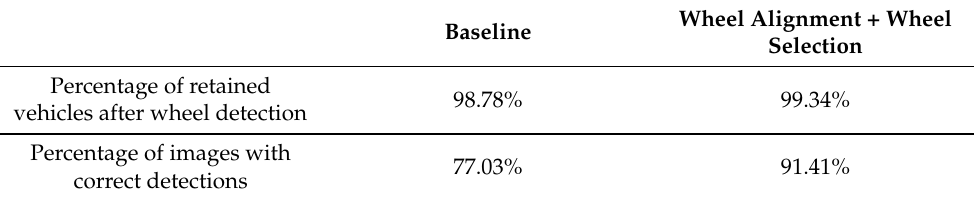
Figure 10. Vehicle images and their detected wheels before and after wheel selection. Table 1. Wheel Detection Approach Performance. (Wheel Selection + Wheel Alignment vs. Wheel